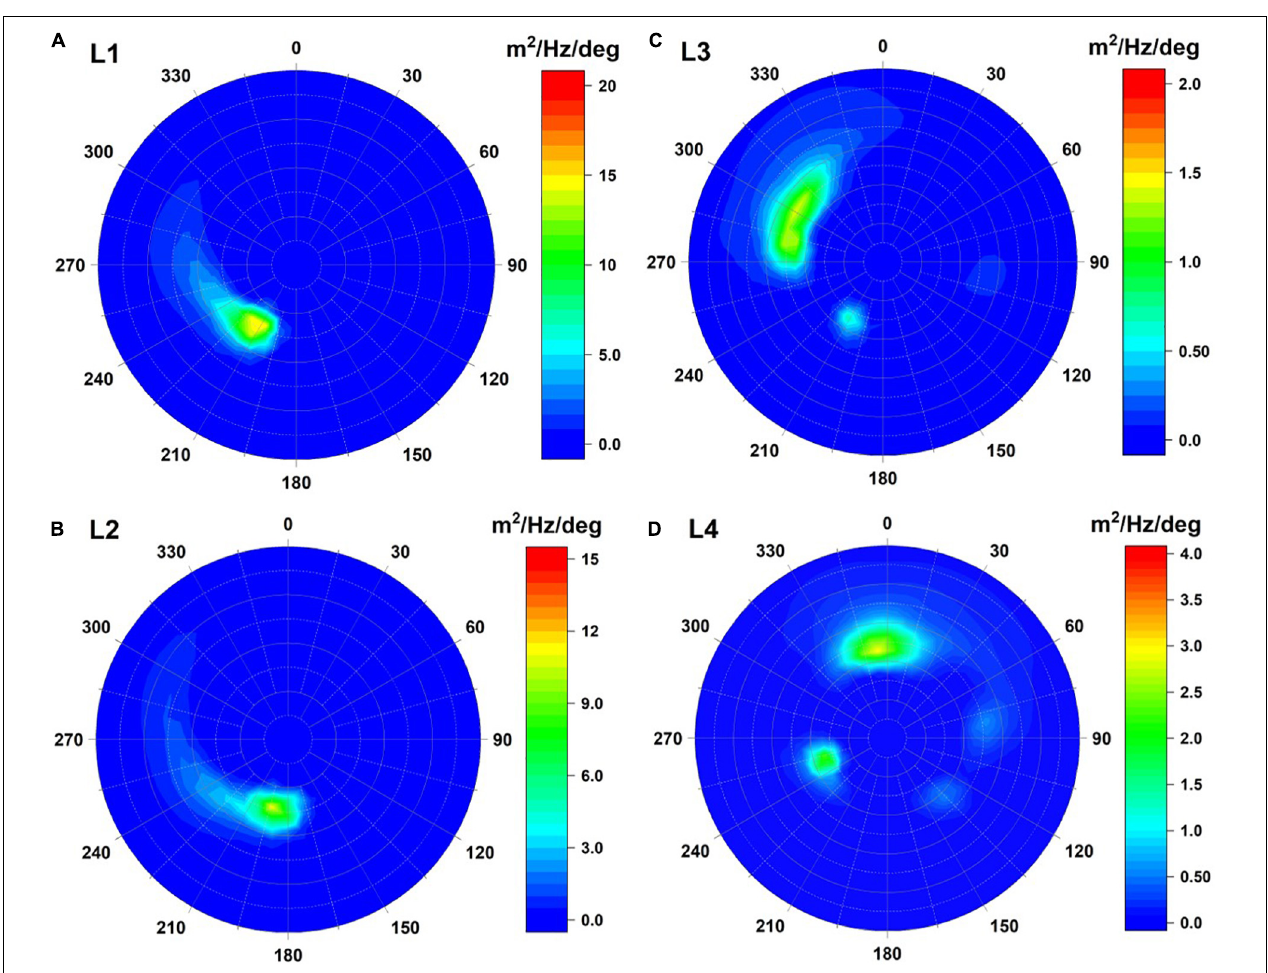
FIGURE 14 | Directional wave spectra generated by Super Typhoon Lekima in 2019 at (A) L1, (B) L2, (C) L3, and (D) L4 four selected representative points at the time of the peak significant wave during single Super Typhoon Lekima (2019).